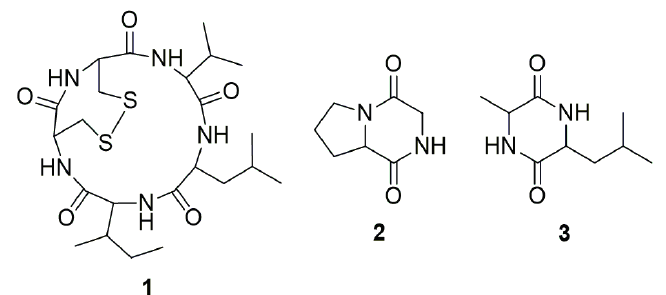
Figure 3. Chemical structures of the cyclic peptides 1 – 3 .